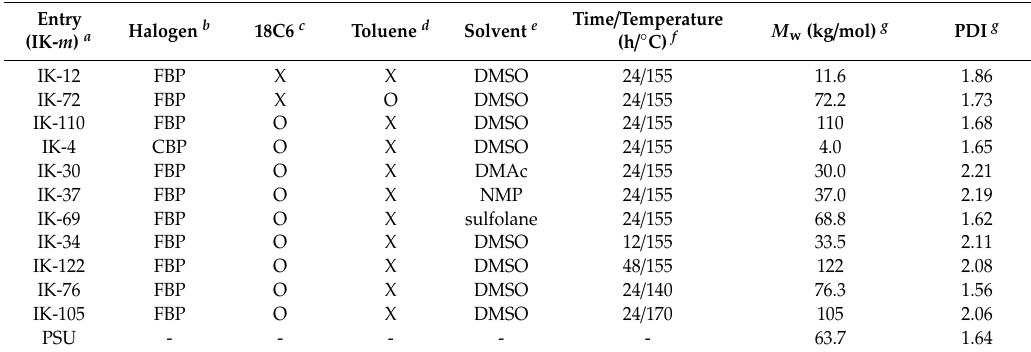
Table 1 summarizes the experimental parameters for the polymerization of other polymers. Table 1. Polymerization information and